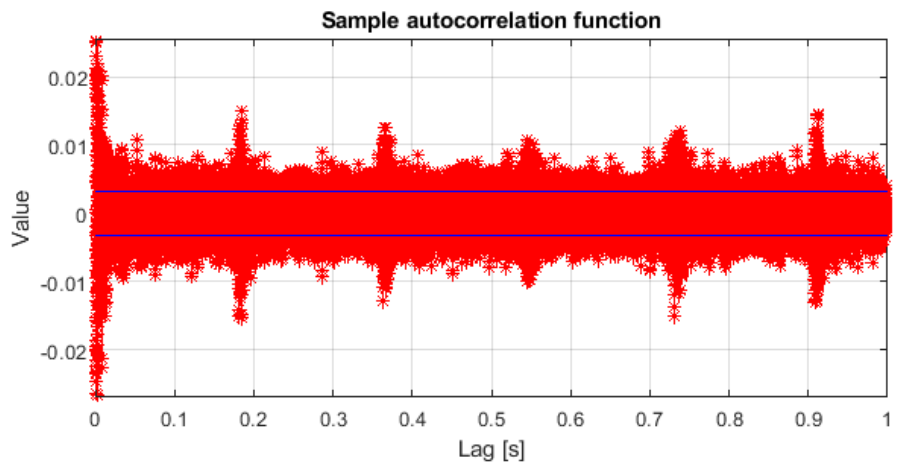
Figure 17. Classic sample autocorrelation